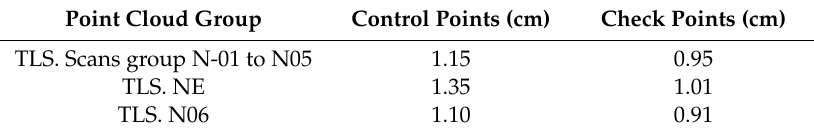
Table 5. Precision Obtained in Absolute Orientation. Control and Check Points.